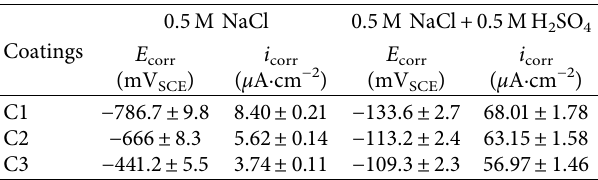
Figure 9: Potentiodynamic polarization curves of as-prepared Ni45 coatings in (a) 0.5M NaCl and (b) 0.5M NaCl +0.5M H Table 2: Corrosion current density ( i corr ) and corrosion potential ( E corr ) of as-prepared Ni45 coatings in 0.5M NaCl and 0.5M NaCl+0.5 mol/L H 2 SO 4 solutions.